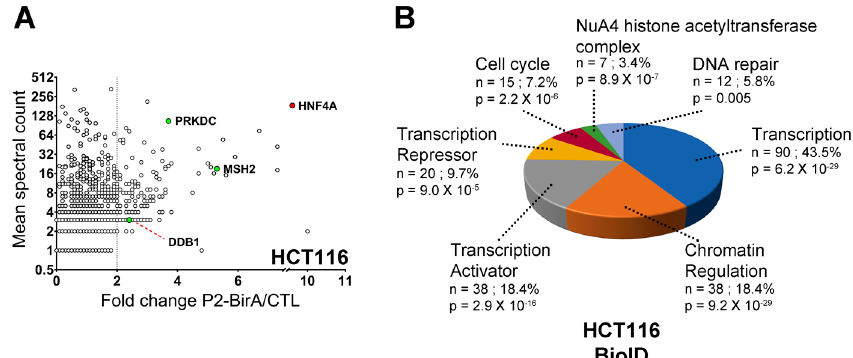
Figure 4. BioID analysis of P2-BirA in the colorectal cancer cell line HCT116 reveals interaction with DNA repairs proteins. ( A ) Distribution of the proteins biotinylated by P2-BirA in the HCT116 cells. The enrichment ratio of each protein in the P2-BirA condition was plotted against its mean spectral count. The proteins that are implicated in the DNA damage response have been highlighted; ( B ) biological function analysis by the software DAVID of the proteins biotinylated by P2-BirA in HCT116 cells. n = number of proteins identified that are associated to that function, % = percentage of the protein pulldowns with P2-GFP that are associated with that function, p = Benjamini corrected p -value.